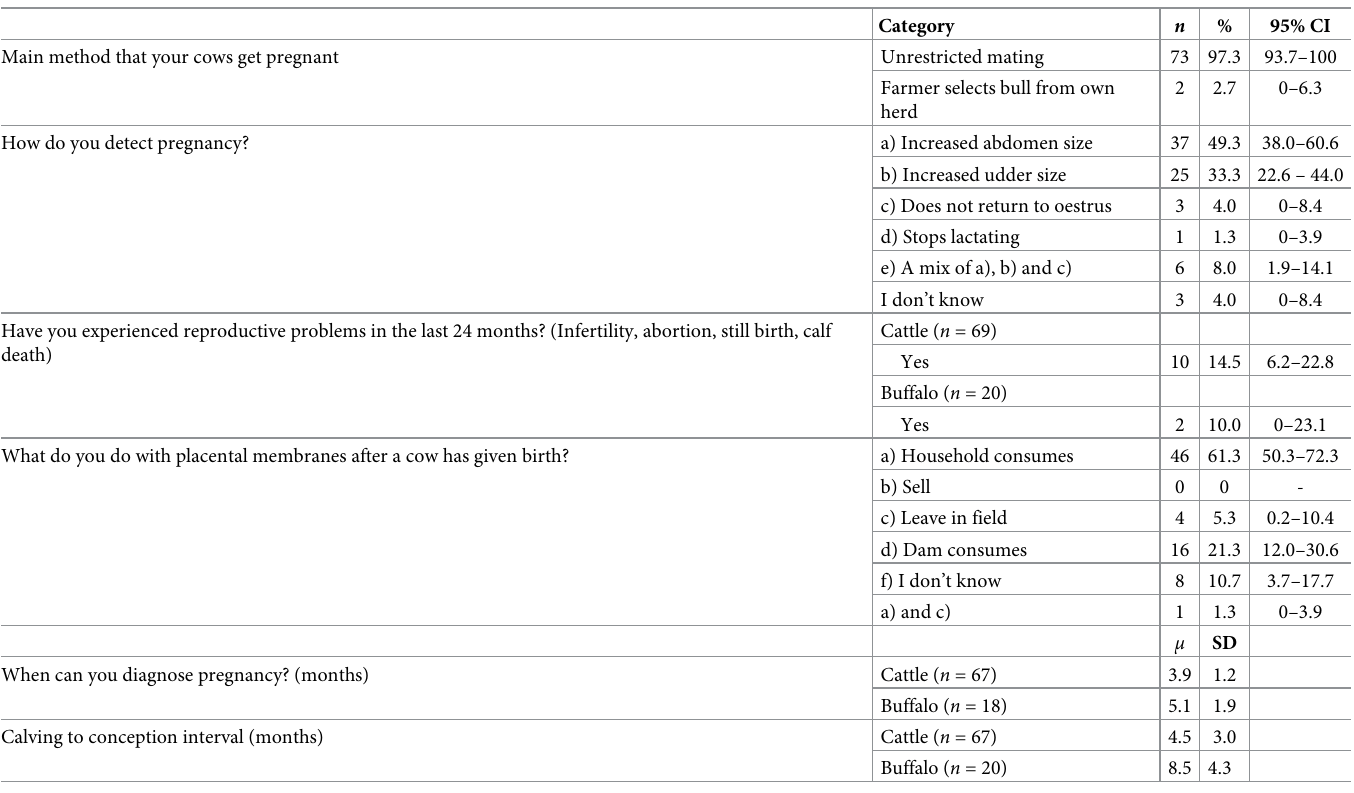
Table 4. Reproductive husbandry practices in smallholder cattle and buffalo farms in Lao PDR from an epidemiological survey ( n =